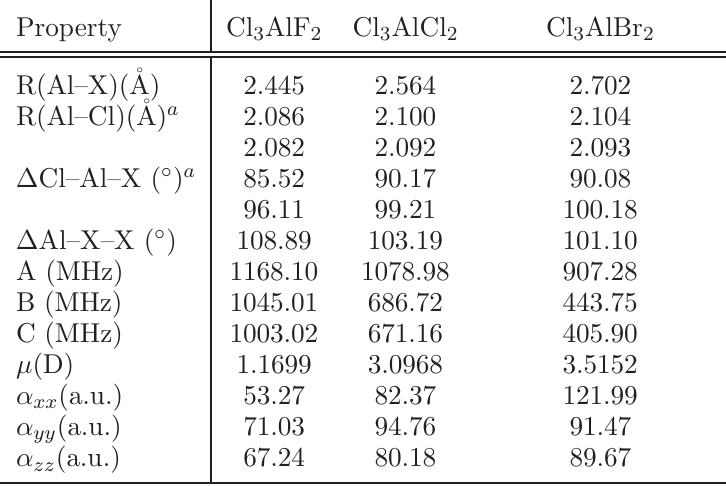
Table 4 Relevant optimized bond lengths and bond angles, rotational constants, dipole moments and static polarizability of the stable Cl plexes (X = F, Cl, and